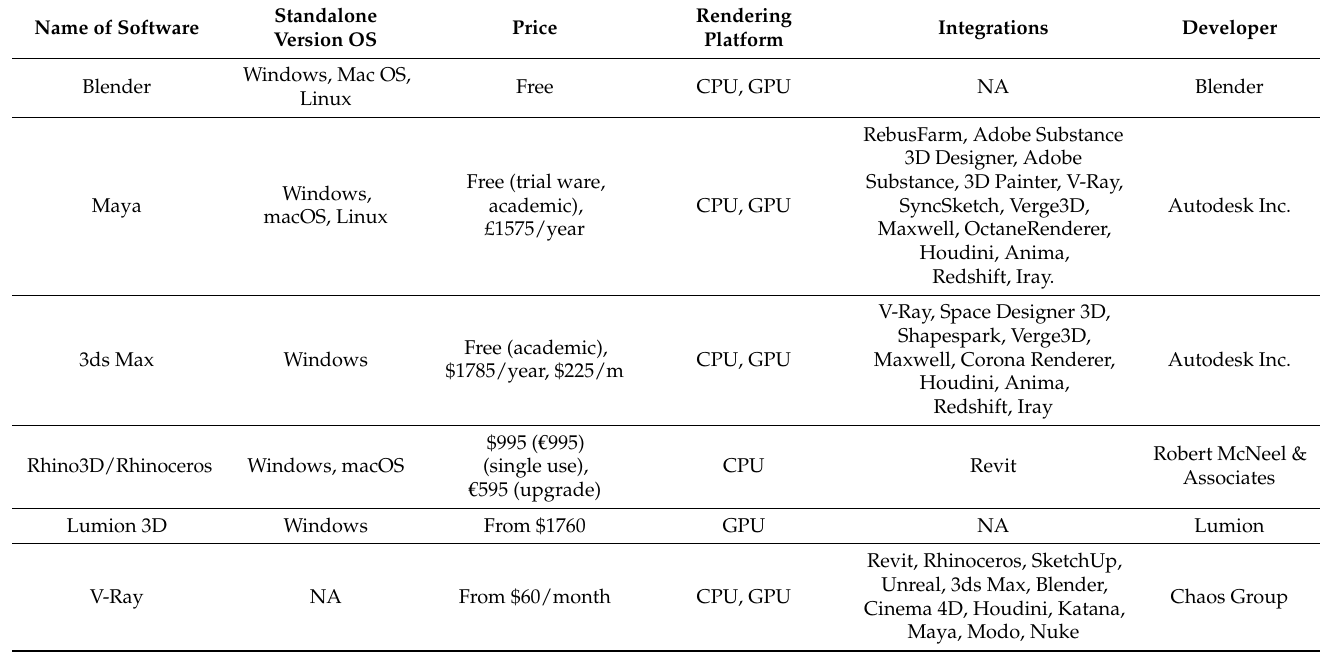
Table 5. Table of some 3D rendering software programs with developer